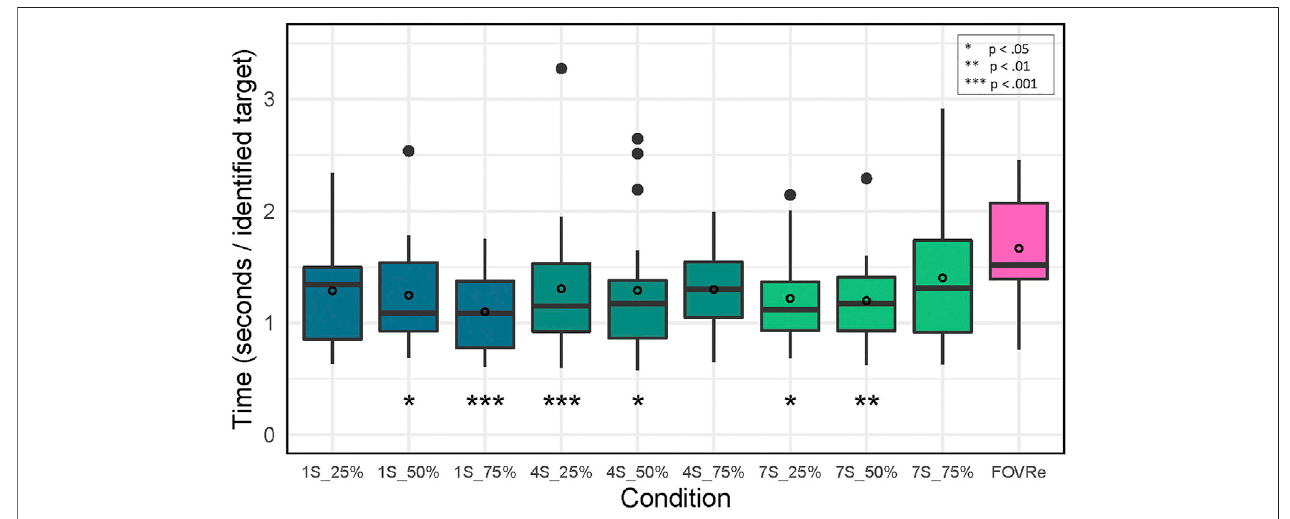
FIGURE 6 | Search time performance. Each variation of GRFs is compared with FOV Restrictors. GRFs combinations 1S_50% ( M (cid:2) 1 . 440 ± 0 . 974), 1S_75% ( M (cid:2) 1 . 236 ± 0 . 692), 4S_25% ( M (cid:2) 1 . 305 ± 0 . 621), 4S_50% ( M (cid:2) 1 . 290 ± 0 . 573), 7S_25% ( M (cid:2) 1 . 382 ± 0 . 837) and 7S_50% ( M (cid:2) 1 . 333 ± 0 . 723) performed